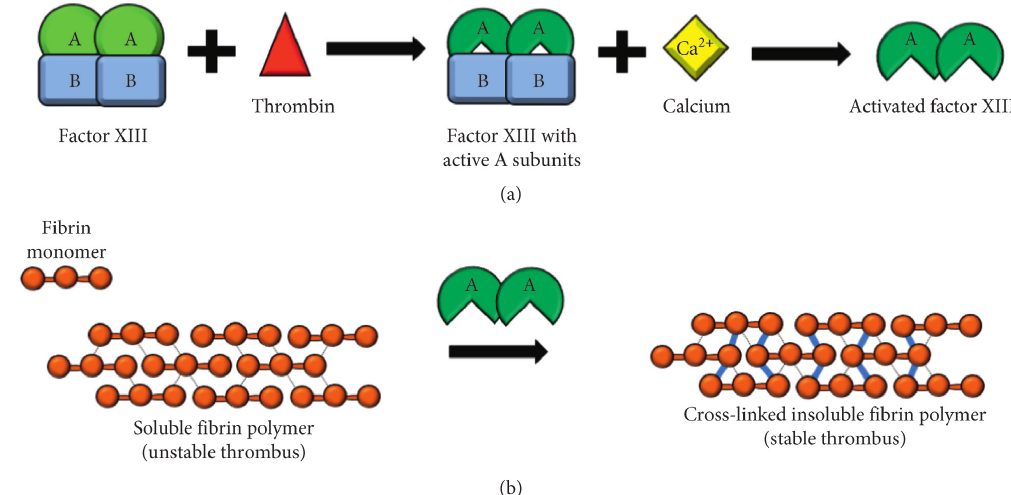
Figure 1: Diagram of factor XIII activation and function. (a) Factor XIII is a protransglutaminase zymogen heterotetramer composed of two catalytic A subunits and two carrier B subunits. Thrombin cleaves the A subunits to make them catalytically active, followed by calcium- dependent dissociation of the B subunit to expose the active enzymatic site on the A subunit. (b) Activated factor XIIIa is then able to crosslink the fibrin strands, by catalyzing the formation of covalent bonds between glutamine and lysine residues on the fibrin a and g chains, resulting in a stable thrombus that is more resistant to degradation and less